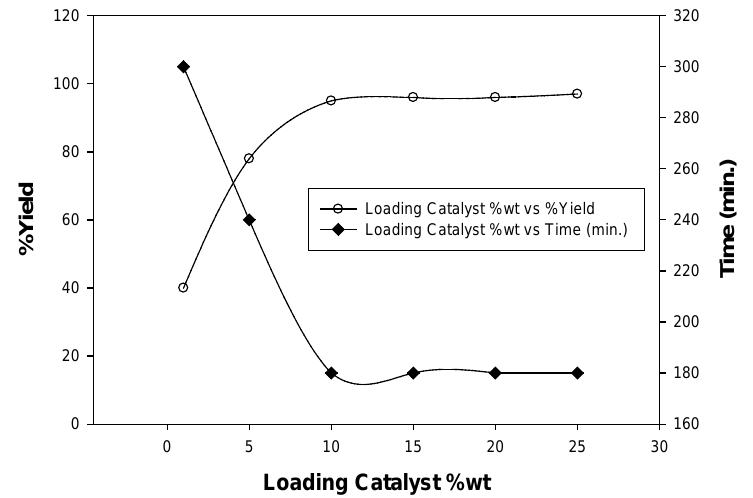
Figure 5. Catalyst loading optimization of the chitosan-aluminum oxide nanocomposite.